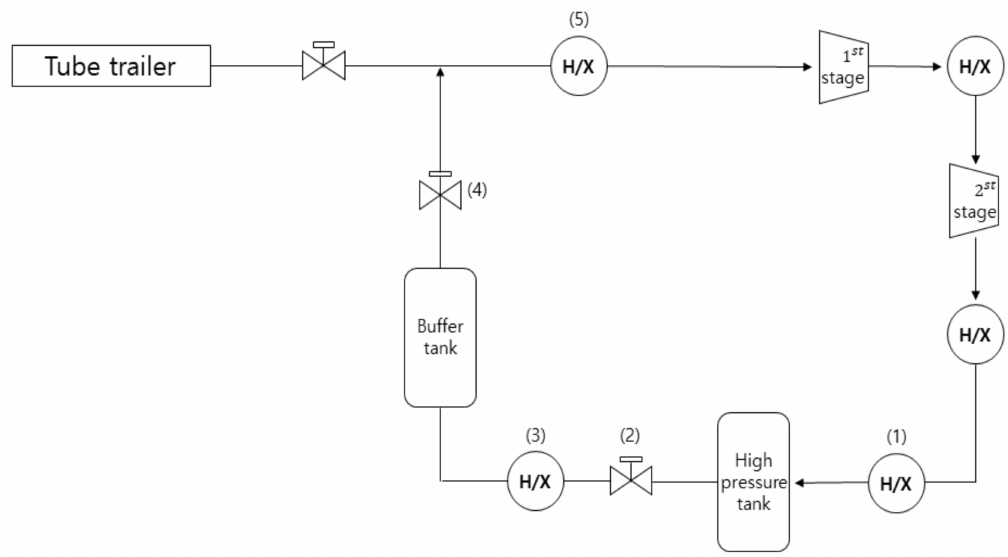
Figure 1. Hydrogen compression